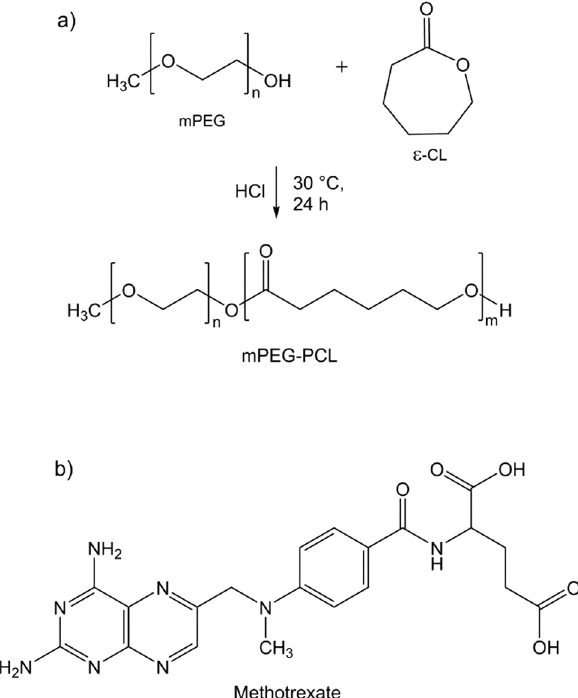
Figure 1: Scheme of ( a ) synthesis and structure of the poly ( ethylene glycol )- b - poly ( ε - caprolactone ) monomethoxy copolymer ( mPEG - PCL ) and ( b ) structure of methotrexate ( 2,4 - diamino - N10 - methyl - propylglutamic acid )